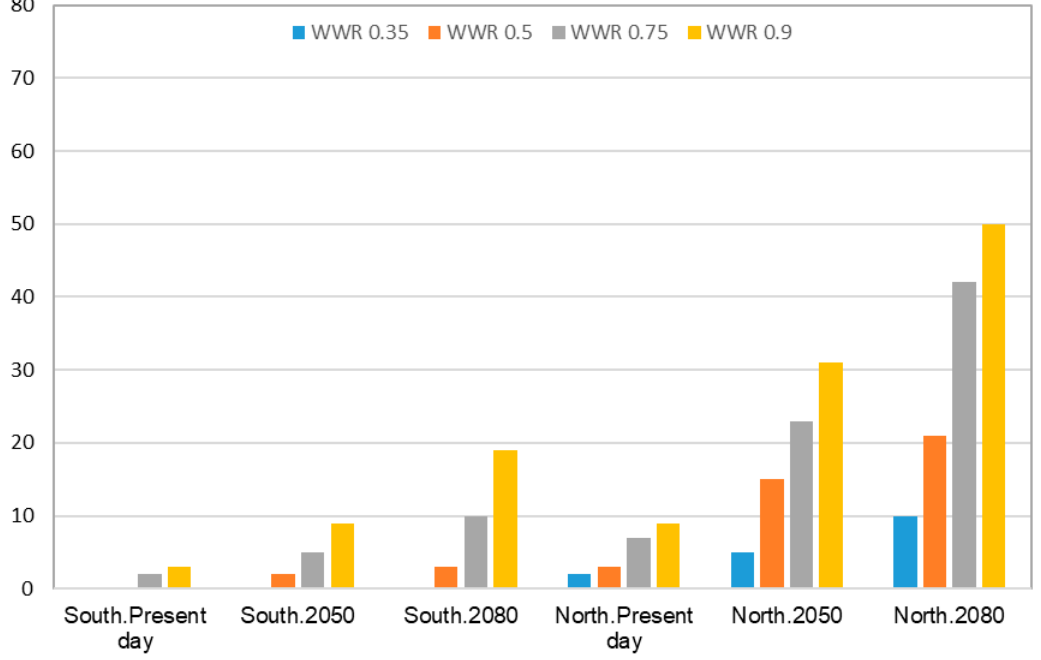
Energies 2019 , 12 , x FOR PEER REVIEW Figure 11. Hours of exceedance 26 ◦ C during the occupied period based on CIBSE TM 59 (Average building). Figure 11. Hours of exceedance 26 °C during the occupied period based on CIBSE TM 59 (Average building).